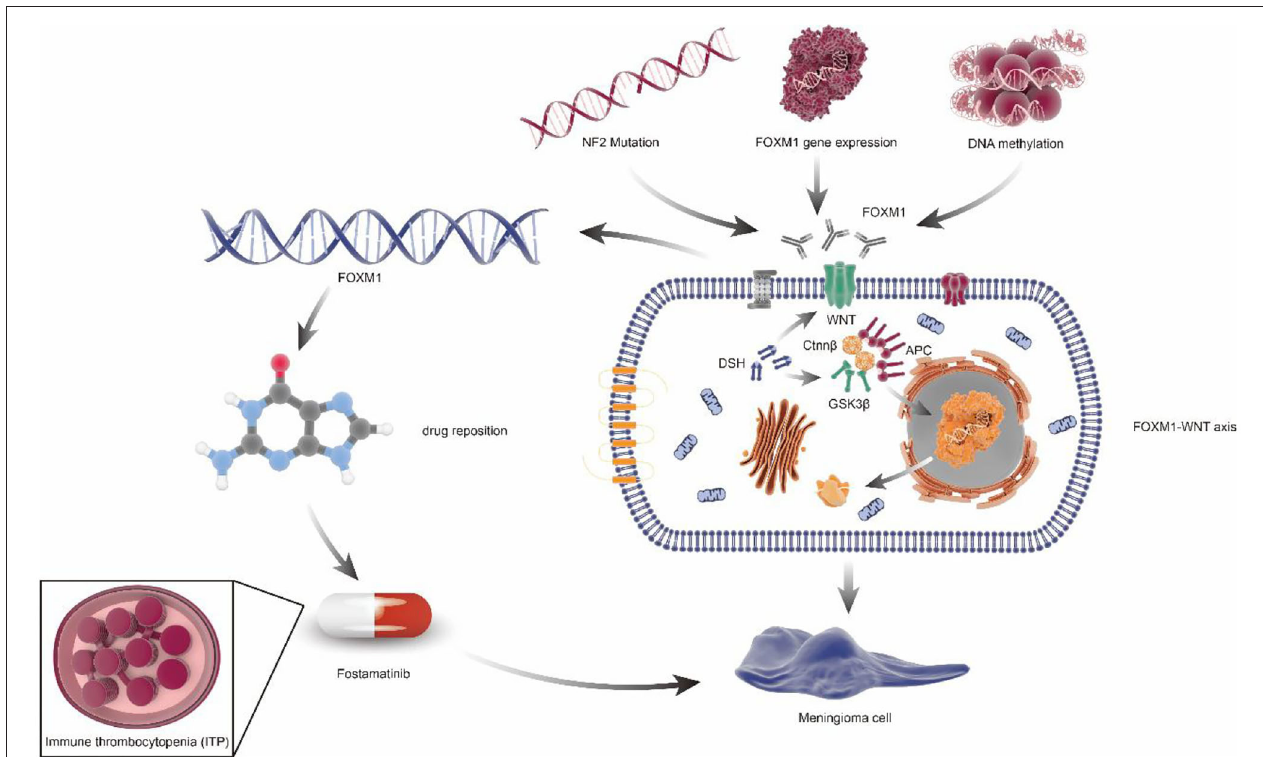
FIGURE 4 | FOXM1/Wnt signaling axis drives meningioma prolife ratio and tumor growth. NF2 mutation, FOXM1 gene expression, and DNA methylation can cause the increase of FOXM1 expression or activity, which would activate the FOXM1/WNT signaling axis, resulting in primary or aggressive meningioma cell proliferation. In addition, through the principle of drug repositioning, fostamatinib, a kind of medicine aimed at chronic immune thrombocytopenia (ITP), which targets the FoxM1, may also be used in the treatment of